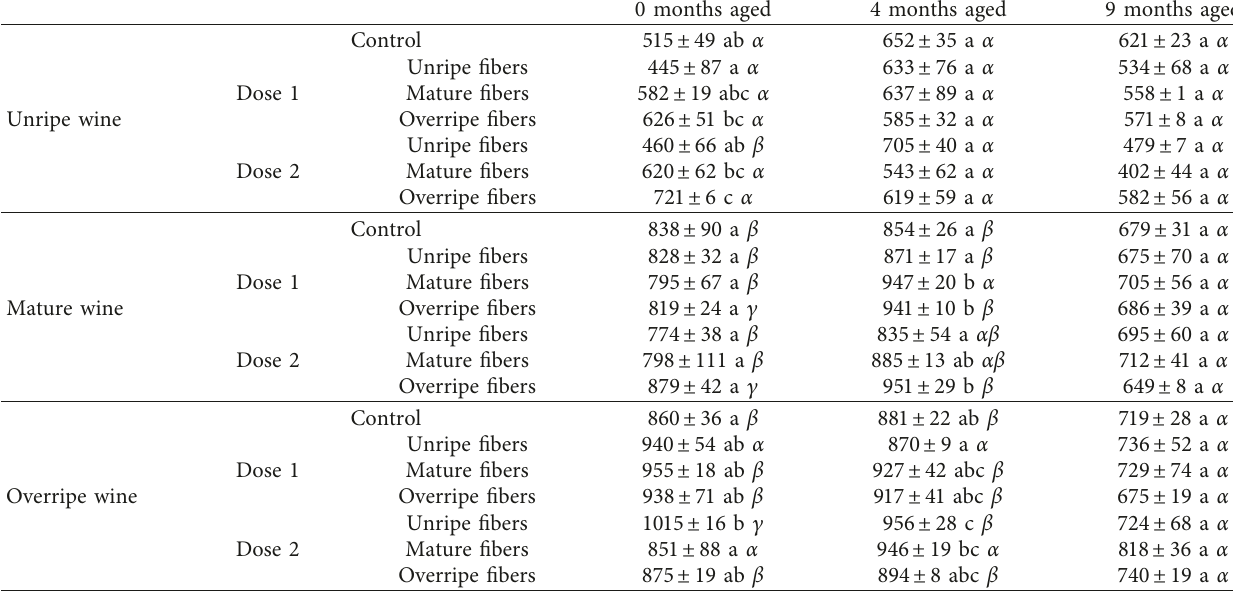
Table 11: Total polysaccharide content of the wines expressed as mg/L.